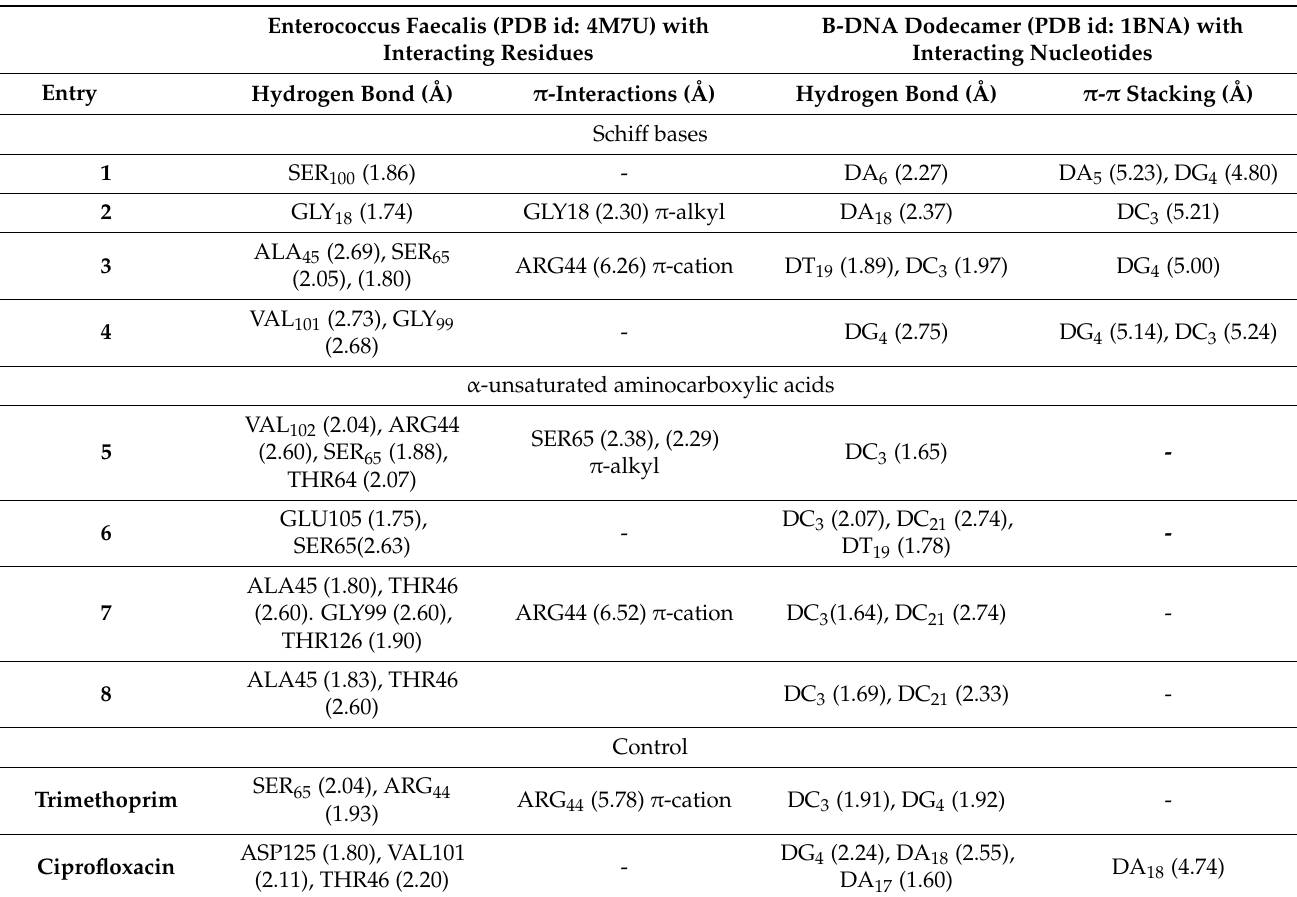
Table 8. Hydrogen bonding and mixed π -interactions of Schiff bases ( 1 – 4 ) and α -unsaturated